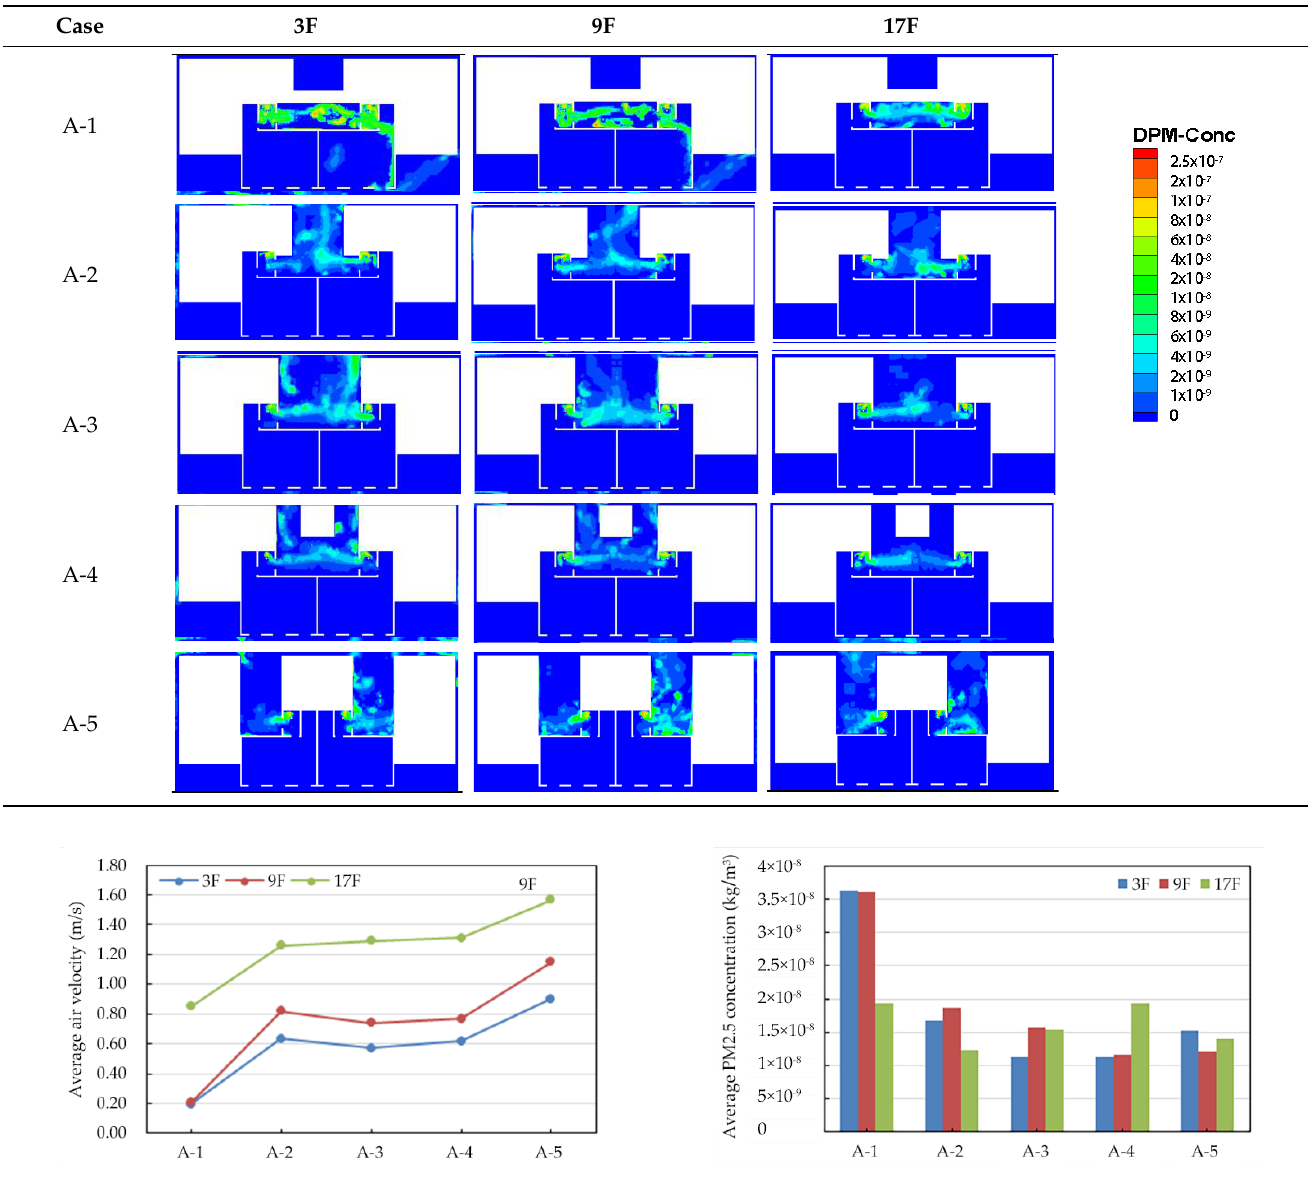
Table 9. Simulation results of PM2.5 distribution for five inner-courtyard variables.